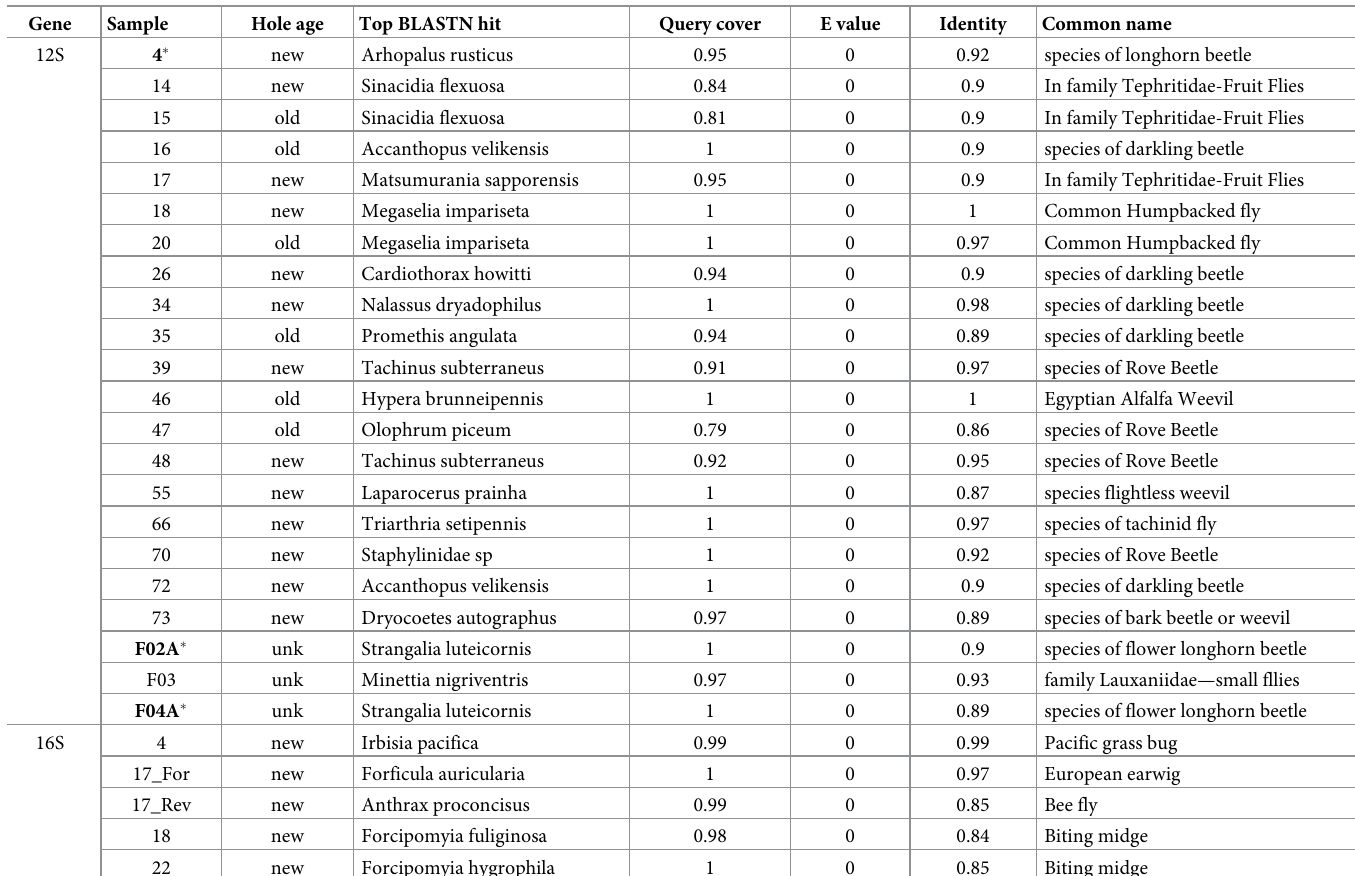
Table 2. Top BLASTN hits for 12S and 16S rRNA frass-derived